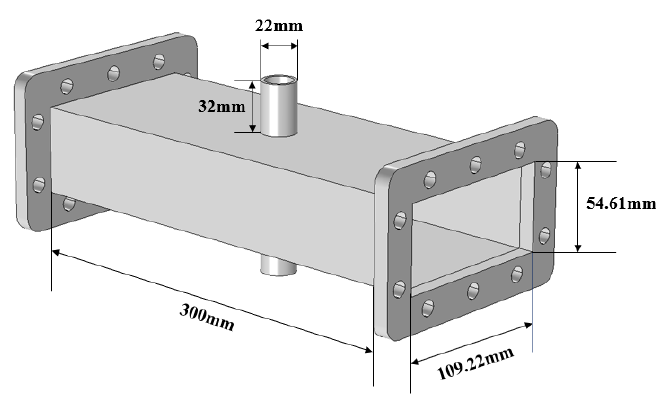
Figure 2. The scheme flowchart.